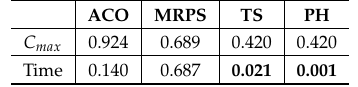
Table 8. Results of Wilcoxon test for the large problems (best results are in boldface).